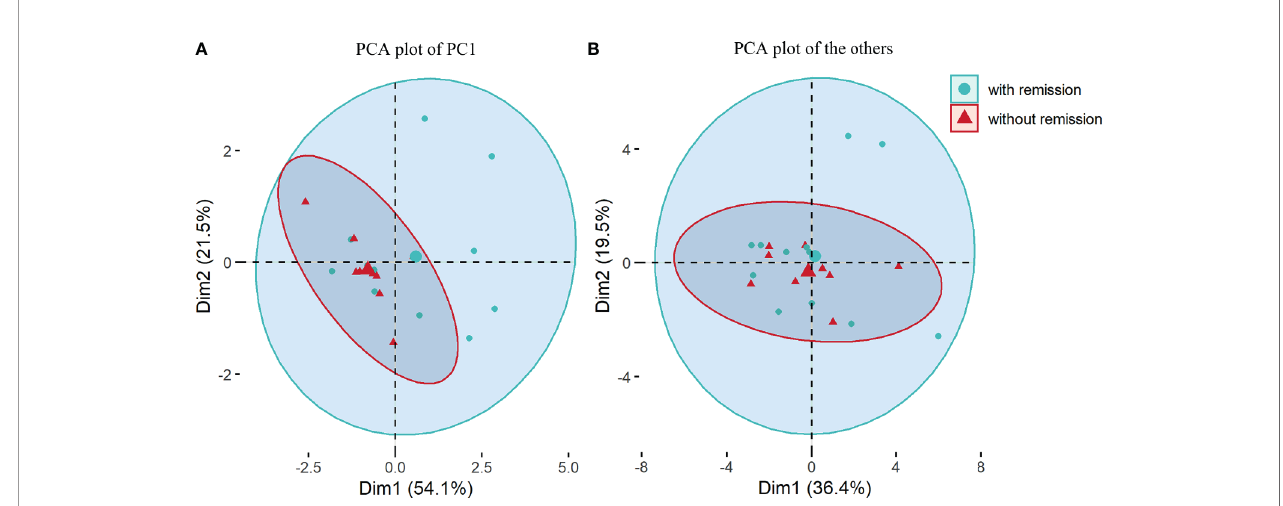
FIGURE 4 | Principal component analysis (PCA) based on 19 multiple cytokines and chemokines. (A) PCA plot for principal component (PC)1 composed of interleukin(IL)-4, IL-10, IL-13 and IL-1 receptor atagonist; (B) PCA plot for 15 other cytokines and chemokines including rotated components (RC)1, RC2 and RC3. Comparisons were between patients with remission and those without remission from NMOSD attacks at 1-month visit.